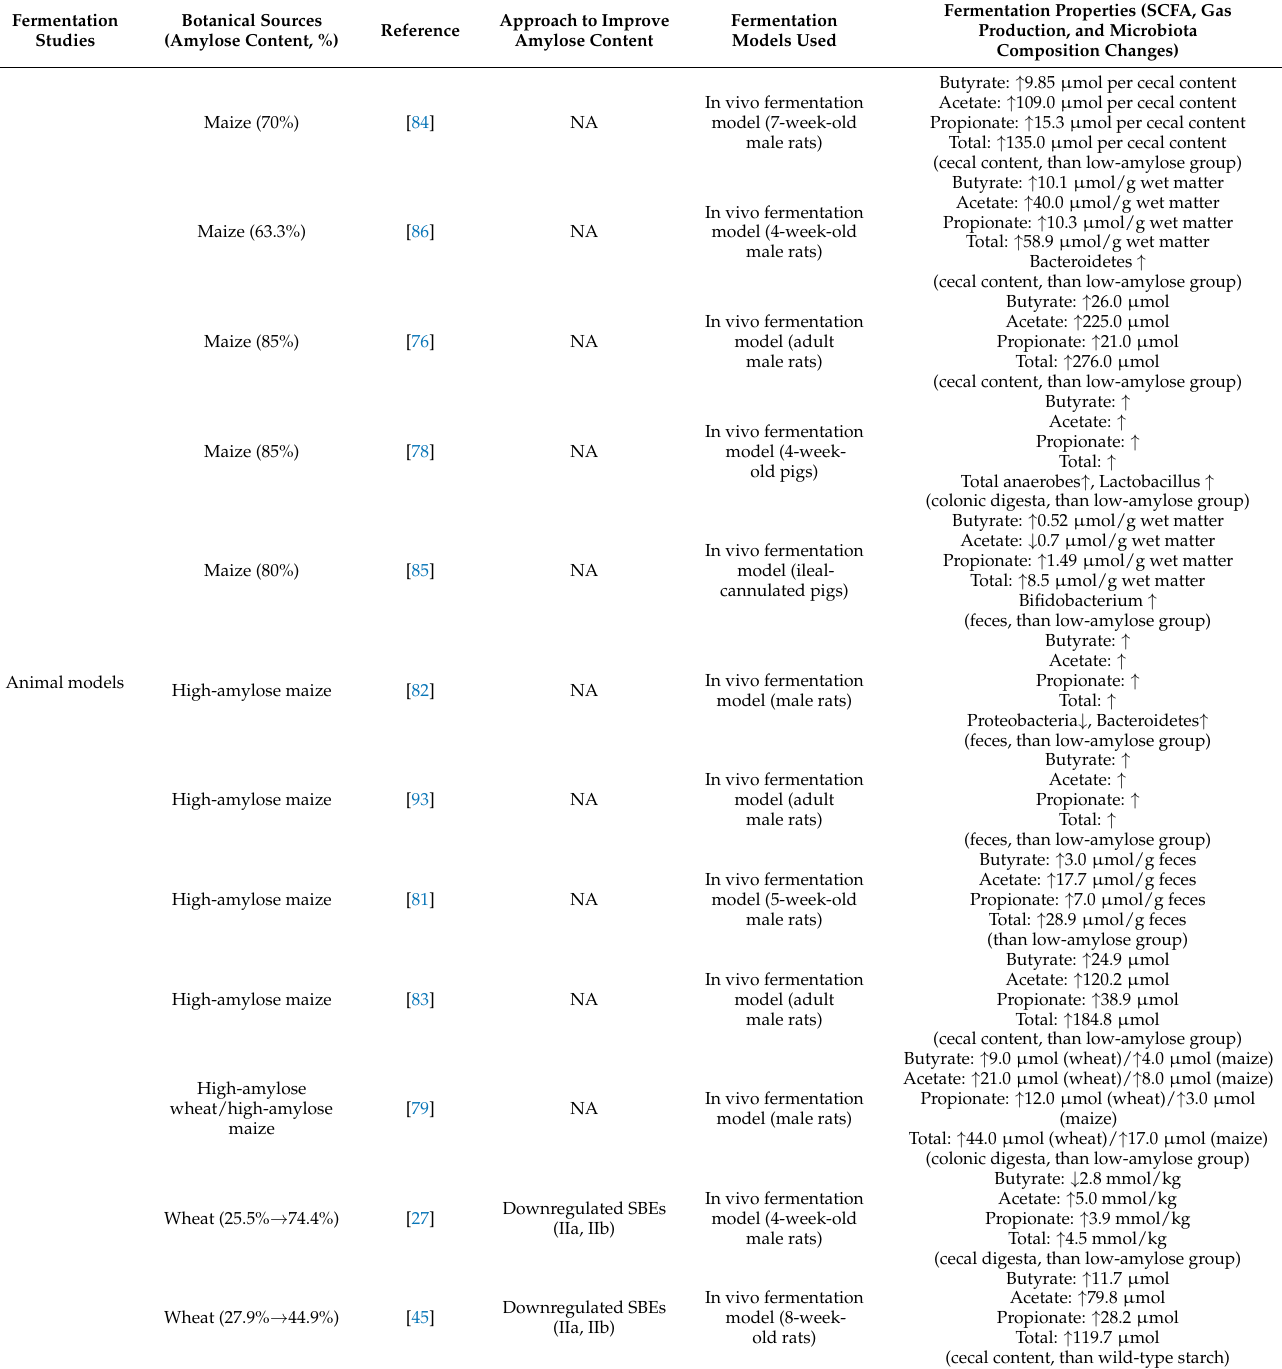
Table 2. Short-chain fatty acid (SCFA) and gas production and microbiota shift of high-amylose starches from in vitro fermentation and animal